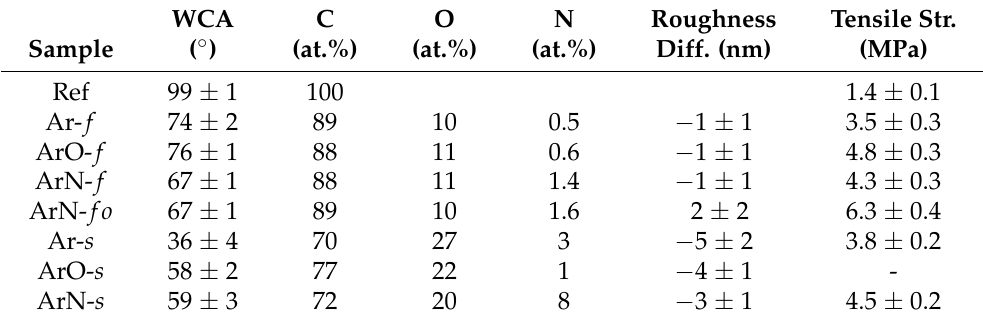
Table 2. Changes in the surface chemistry of plasma-treated PP samples characterized by water contact angles of a sessile drop, average atomic concentrations (without H), differences in the surface roughness measured before and after the treatment, and by tensile strengths derived from the single lap joint shear test. The error of the atomic concentration measurement was ∼ 1 at.%. The conditions used for treating the samples are shown in Table